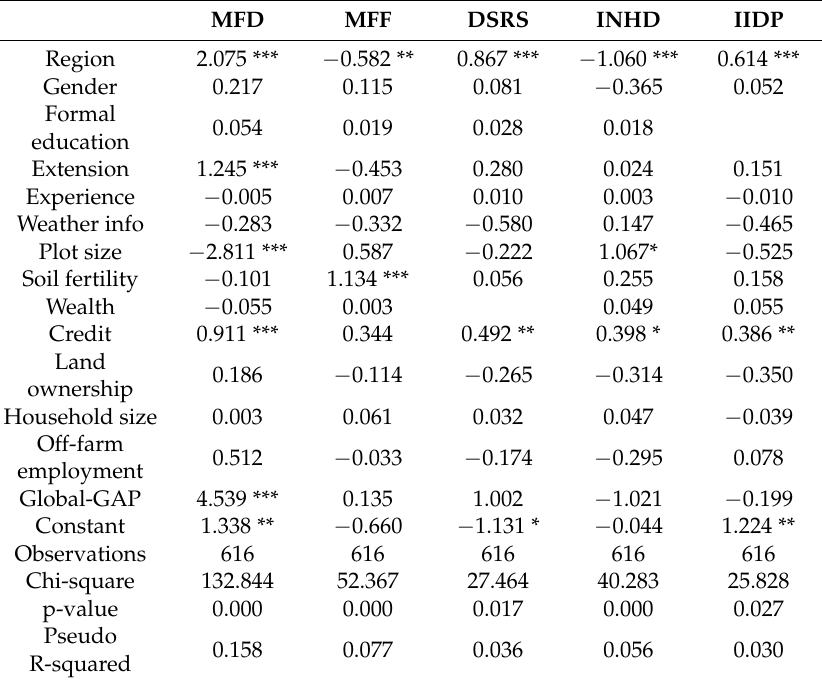
Table 4. Factors influencing climate change